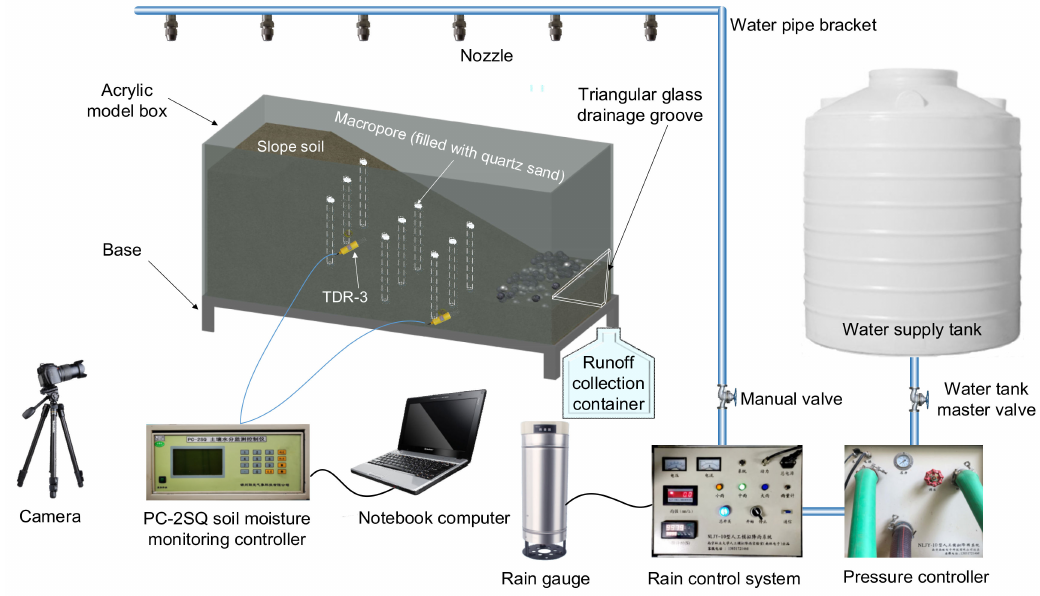
Figure 4. Test setup and instrumentation